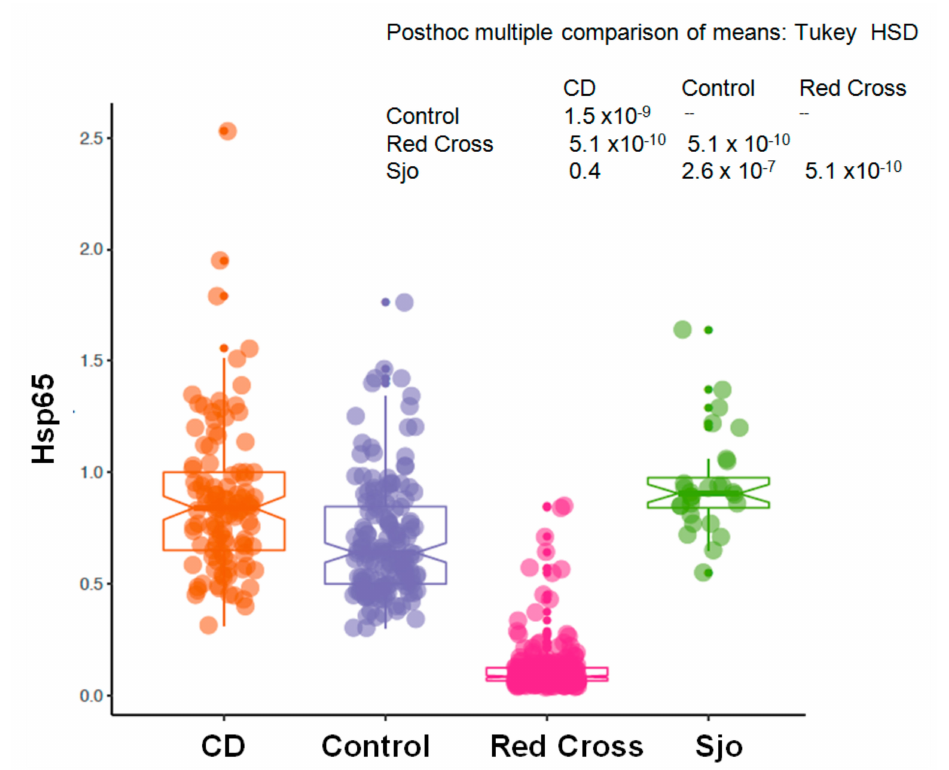
Figure 1. Blood levels of Hsp65 antibody in a normal population (Red Cross donors, n = 288), Crohn’s disease (CD, n = 109), Sjogren’s syndrome (Sjo, n = 28), and the controls from physician’s o ffi ce (Control, n = 156). Y-axis represents the raw reading unit of OD450.